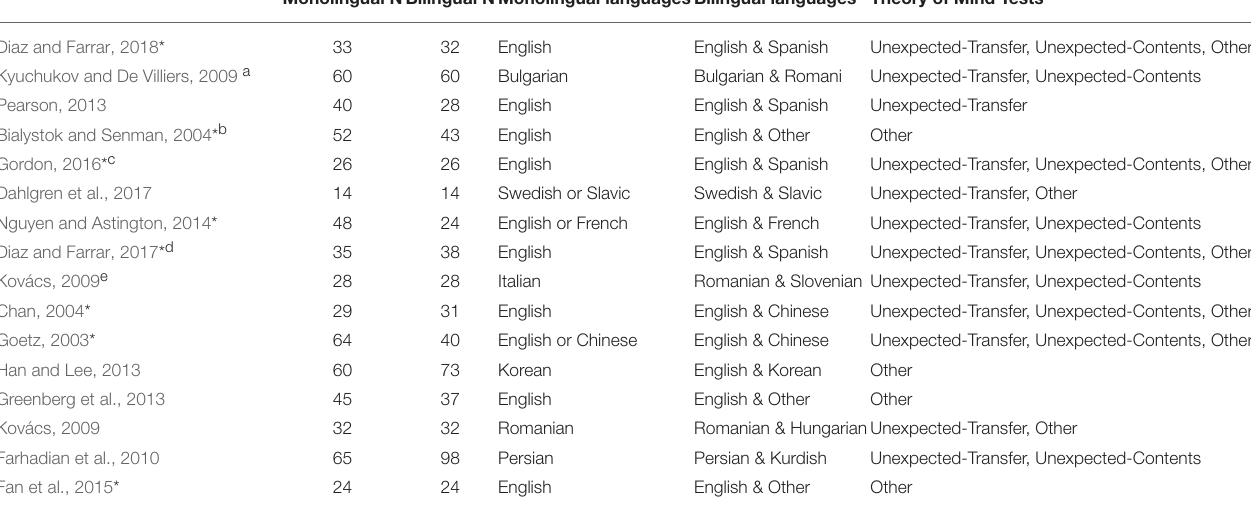
TABLE 1 | Studies included in main analysis.